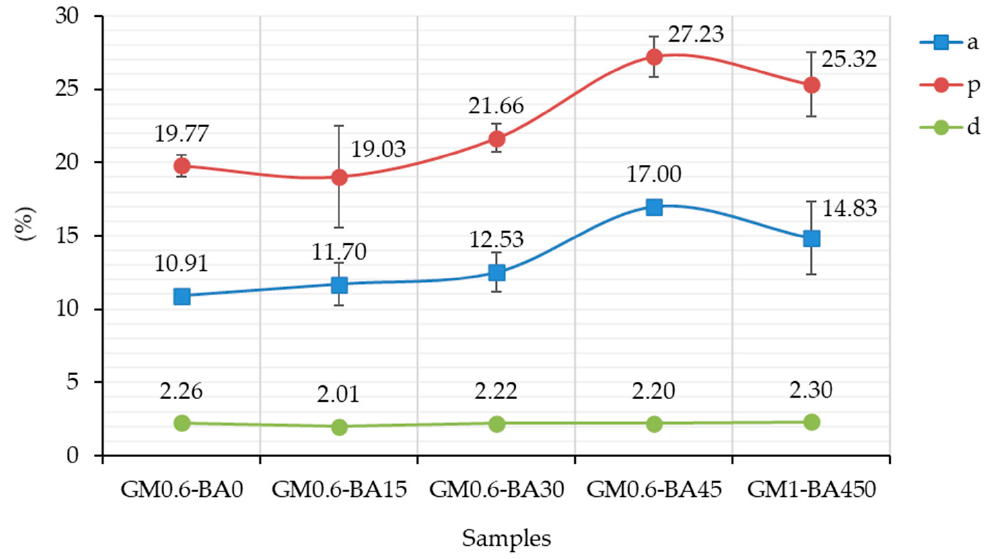
Figure 3. Average values of water absorption (a), apparent porosity (p) and bulk density (d) for samples.